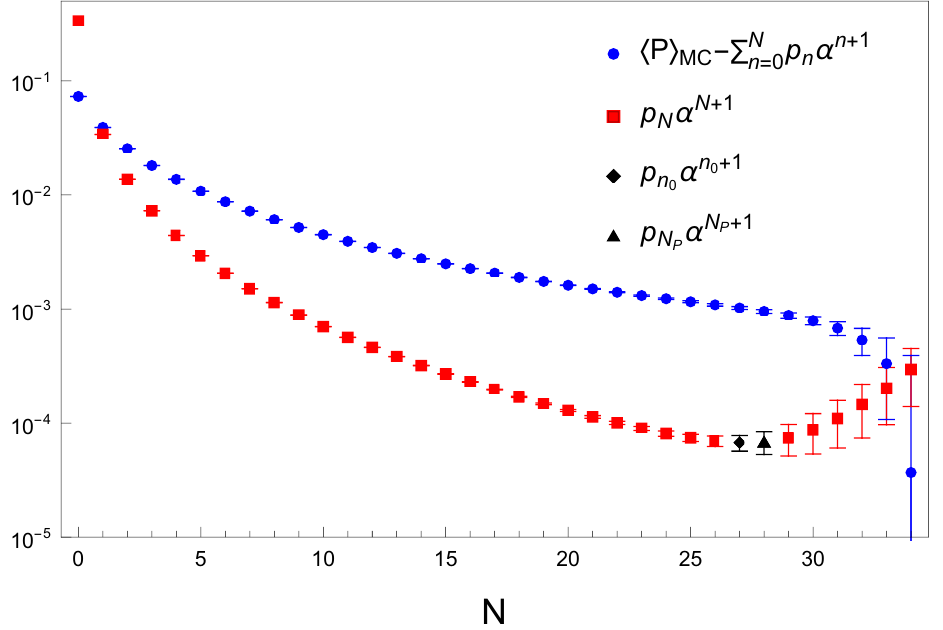
Figure 4 . We draw h P i MC (cid:0) P N p n (cid:11) n +1 (full blue circle points), and p N (cid:11) N +1 (full red squares n =0 points) for di(cid:11)erent values of N up to N = 34 for (cid:12) = 6. The error of the blue points is the statistical error of the MC simulation and of the sum P N p n (cid:11) n +1 combined in quadrature (for n =0 large N the error of the perturbative sum is dominant). The error displayed here of the perturbative sum does not include the systematic error of the in(cid:12)nite volume extrapolation of the coe(cid:14)cients p n . The error displayed for the red points is the complete error (statistical plus systematic combined in quadrature) of the p N coe(cid:14)cient obtained in [2] times (cid:11) N +1 . The black diamond stands for the numerical minimal value of p N (cid:11) N +1 . The black triangle is p N (cid:11) N P +1 using the smallest positive P c that makes N P to be integer in eq. (1.11). Note that the plus/minus error does not display symmetrically in the plot because of the logarithmic